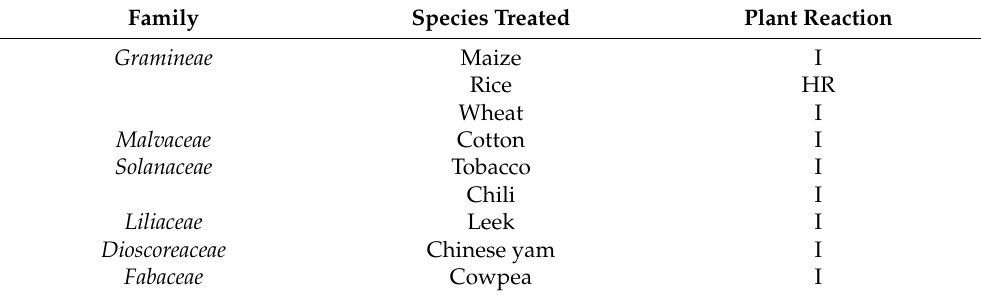
Figure 2. Phylogenetic tree showing the phylogenetic position of strain B-48 using the neighbor- joining (NJ) method based on concatenated ITS, Sod2, Mat1, and Apn2 gene sequence. The numbers at the nodes indicate the levels of the bootstrap support percentages based on the neighbor-joining of 1000 replicates. The scale bar represents a 0.01 sequence difference. The GenBank accession numbers for the fungal isolates used in the analysis are provided (Table S1). Table 1. Host susceptibility of Colletotrichum echinochloae in major summer crops and plants in Hubei